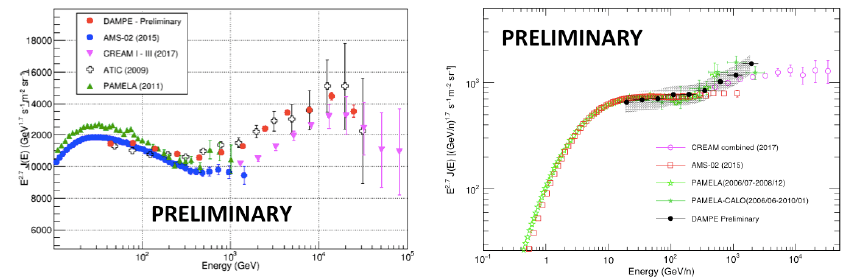
Figure 6. Spectra of protons (left panel) and helium nuclei (right panel).